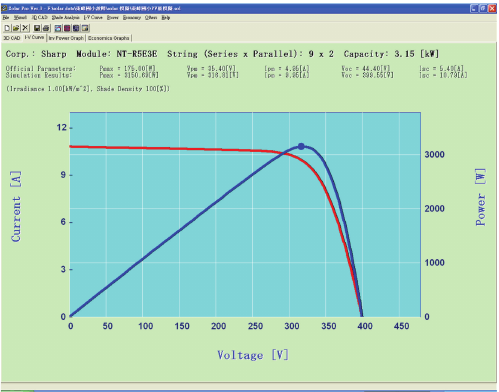
Figure 1: The P-V and I-V characteristic curves of a 3.15kW photovoltaic power generation system simulated by Solar Pro under 1,000W/m 2 irradiation and a module temperature of 25 ∘